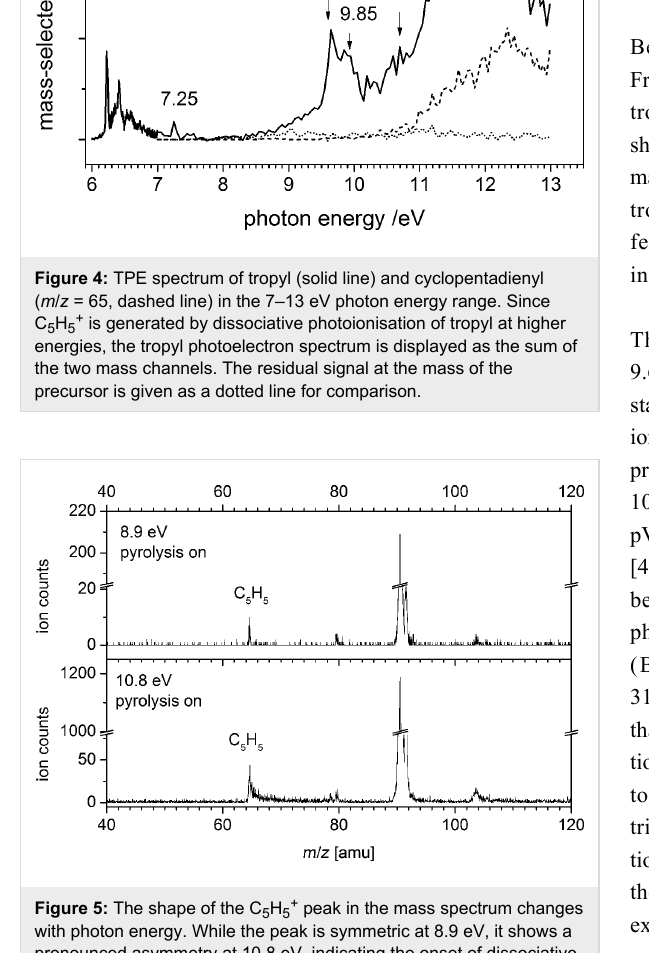
becomes asymmetric, as visible in the lower trace of Figure